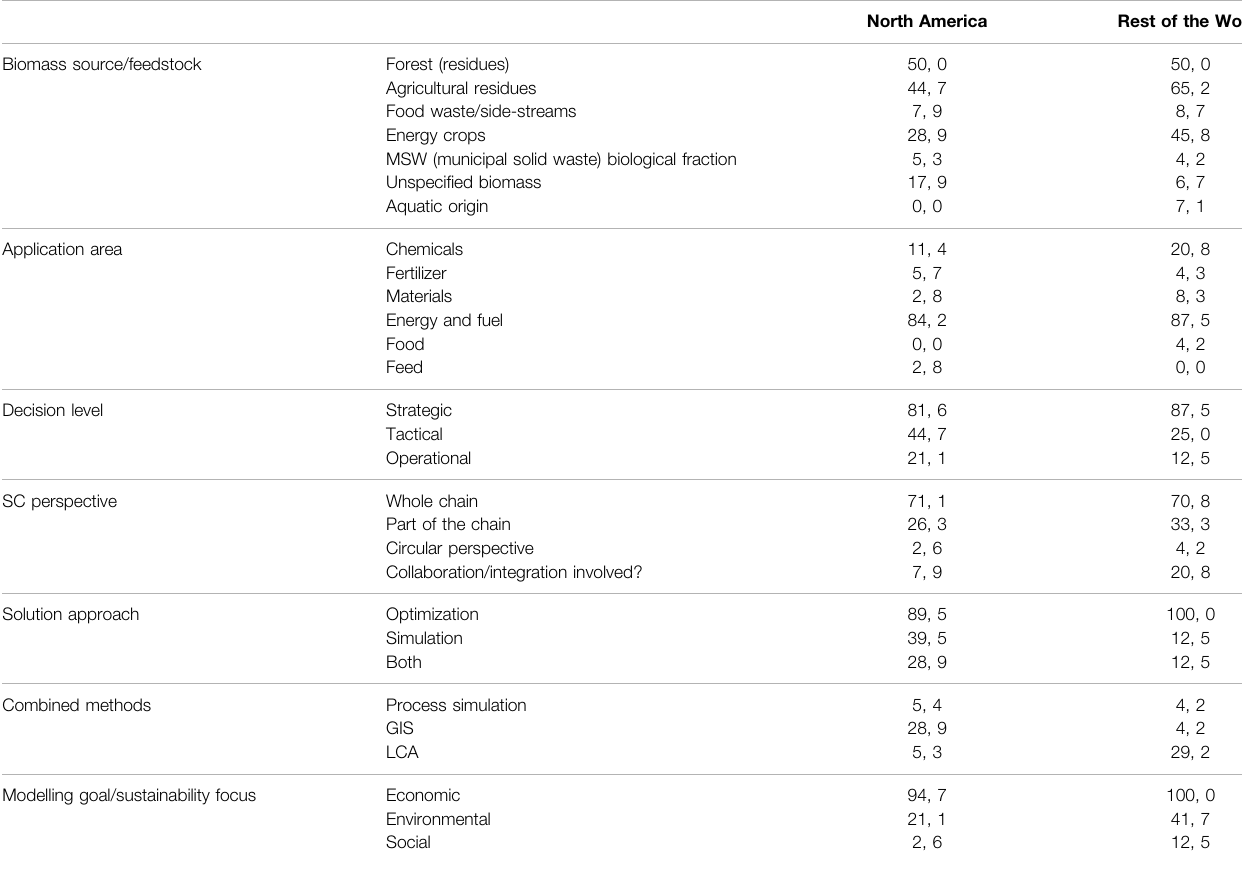
TABLE 6 | Cross-categoric analysis between geographical location and the other